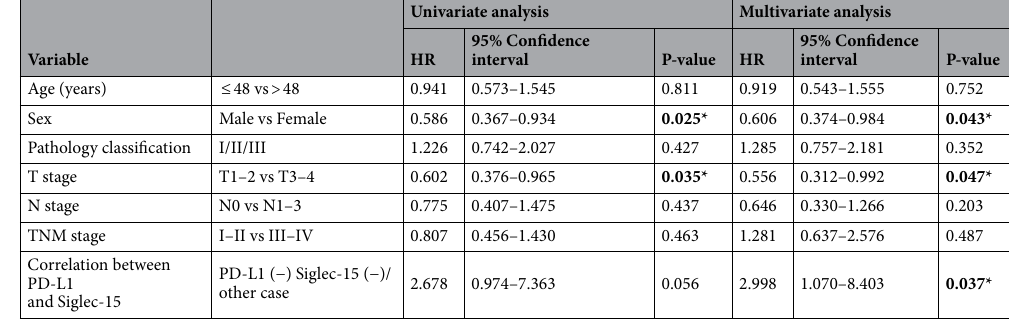
Table 6. Univariate and multivariate Cox proportional hazard analyses of clinicopathologic variables for the OS rate. Siglec-15 Sialic acid-binding immunoglobulin-like lectin 15, PD-L1 programmed cell death-Ligand 1, WHO World Health Organization, OS overall survival. The bold value represents p>0.05, indicating that the difference is statistically significant.